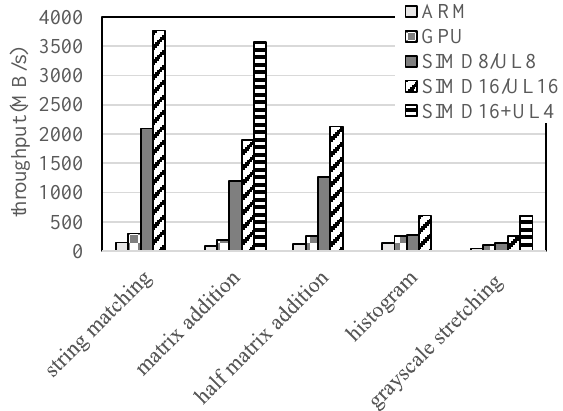
Figure 10. Throughputs of the single servant running on single accelerator with different optimization parameters. SIMD v and UL w mean the servant runs on FPGA with SIMD and UL strategies, and the subscript numbers represent the parallelism of the computing units.